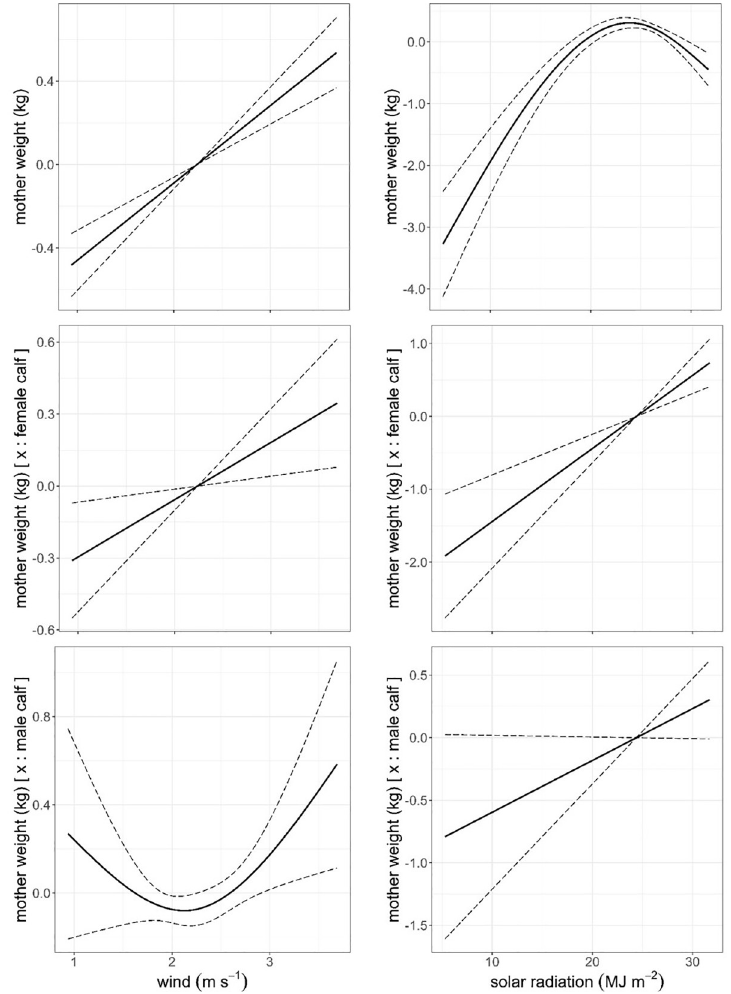
Fig 7. Predicted mother weight (kg) against daily mean wind speed (m � s -1 ) and solar radiation (MJ � m -2 ) and the additive effect of bearing a male or a female through lactation from model in Table 6. Dashed line: ± standard error. Response variable has been centred by subtraction of the mean